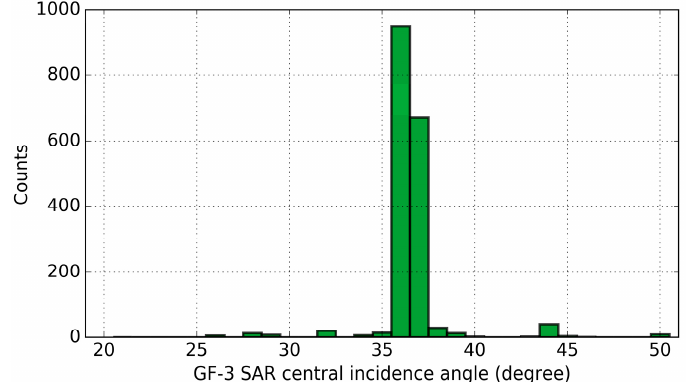
Figure 2. Central incidence angle distribution of the collected GF-3 SAR data.